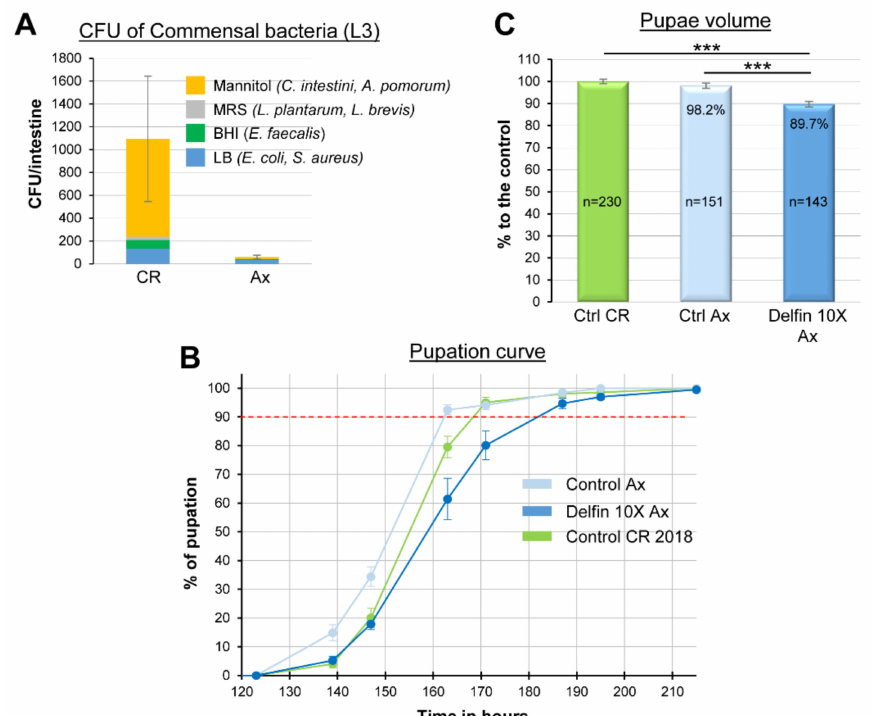
Figure 5. Btk bioinsecticides interaction with commensal flora ( A ) Commensal bacterial load in the midgut of L3 of Drosophila Canton S strain reared on conventional medium (CR, left bar) or reared in axenic condition (Ax, right bar). The Commensalibacter intestini and Acetobacter pomorum grow on mannitol plate (orange), L plantarum and L brevis grow on MRS plate (gray), Enterococcus faecalis grows on BHI plate (green) and Escherichia coli and Staphylococcus aureus grow on LB plate (blue). ( B ) Pupation curve of axenic larvae raised on a medium contaminated with Delfin 10X (dark blue) or not (light blue, control Ax) compared to larvae conventionally reared (CR, green). 171 < n < 211. ( C ) Pupae volume derived from conventionally reared larvae (green) or from axenic larvae raised on a sterile medium contaminated with Delfin 10X (dark blue) or not (light blue). Errors bars represent the SEM. *** p < 0.001 compared with